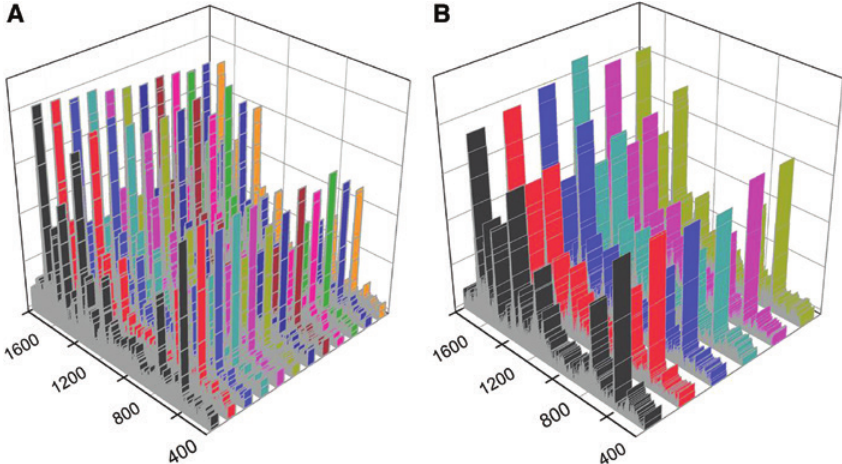
Figure 8: (A) (B) Raman spectra of the Au/Si/Au clusters with a 1-nm-thick Si interlayer after continuous measurements for 12 times and the spectra for six different points.